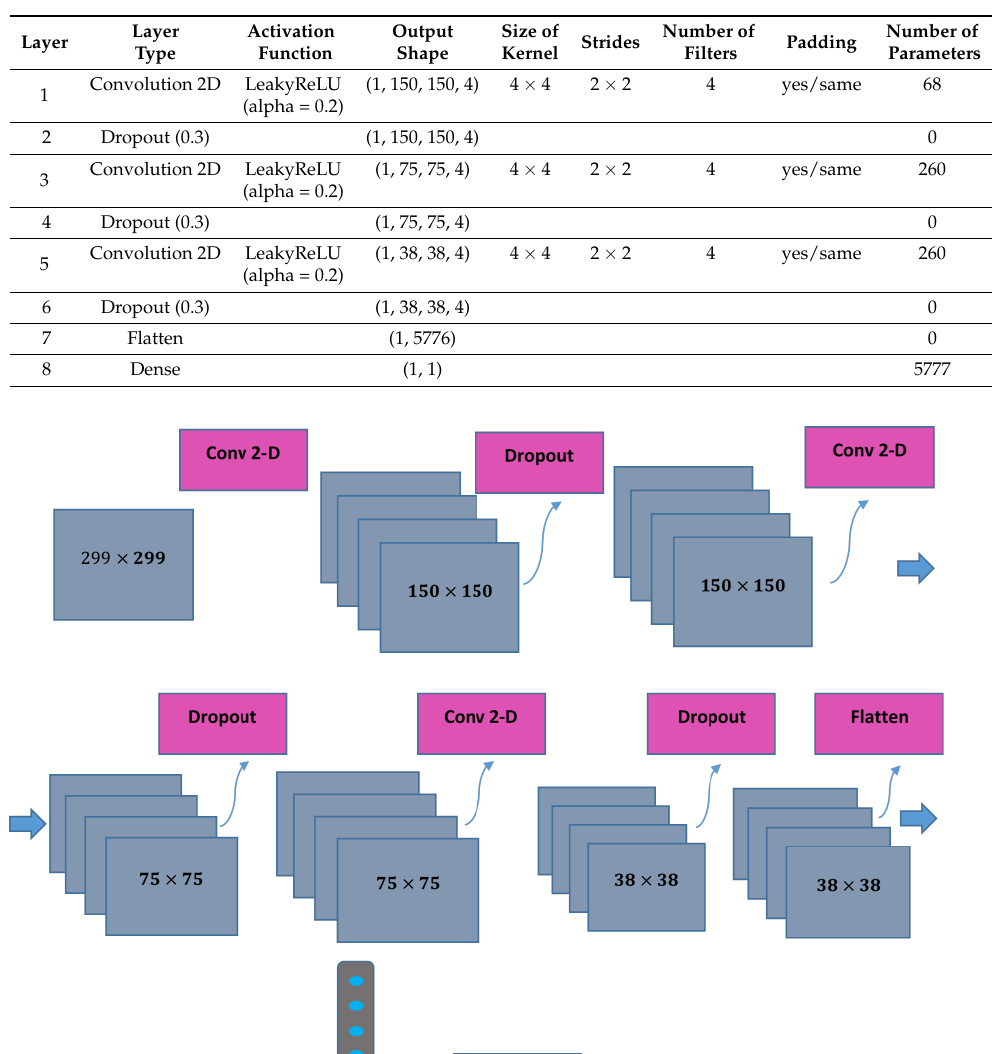
Table 3. Details of the discriminator part of the proposed GDN-GAN architecture.